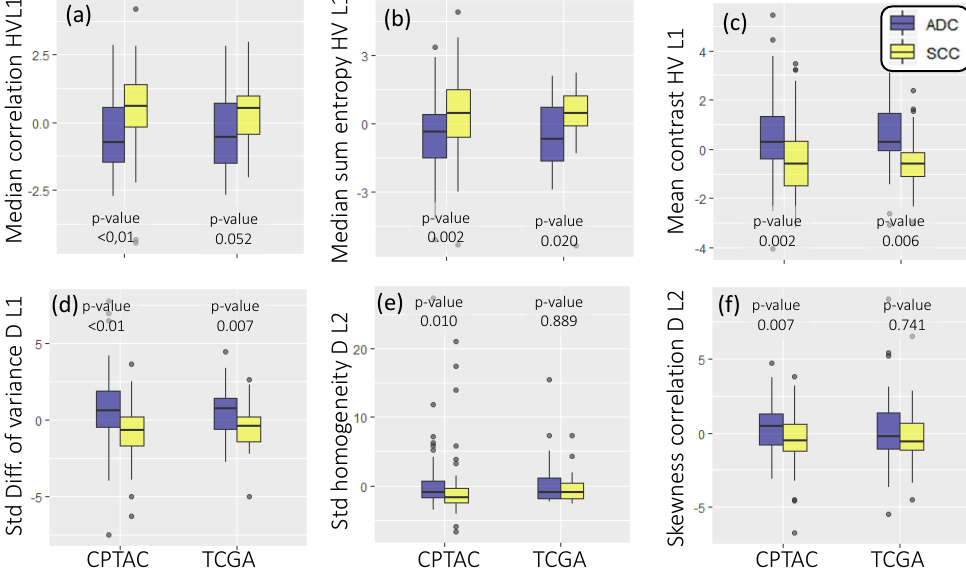
Figure 5. Box plots ( a – f ) of the six top-ranked pathomics features together with their p -value from Wilcoxon ranksum testing (unadjusted), when comparing ADC (blue) to SCC (yellow). Box plots are presented for both histopathological datasets considered, CPTAC (training) and TCGA